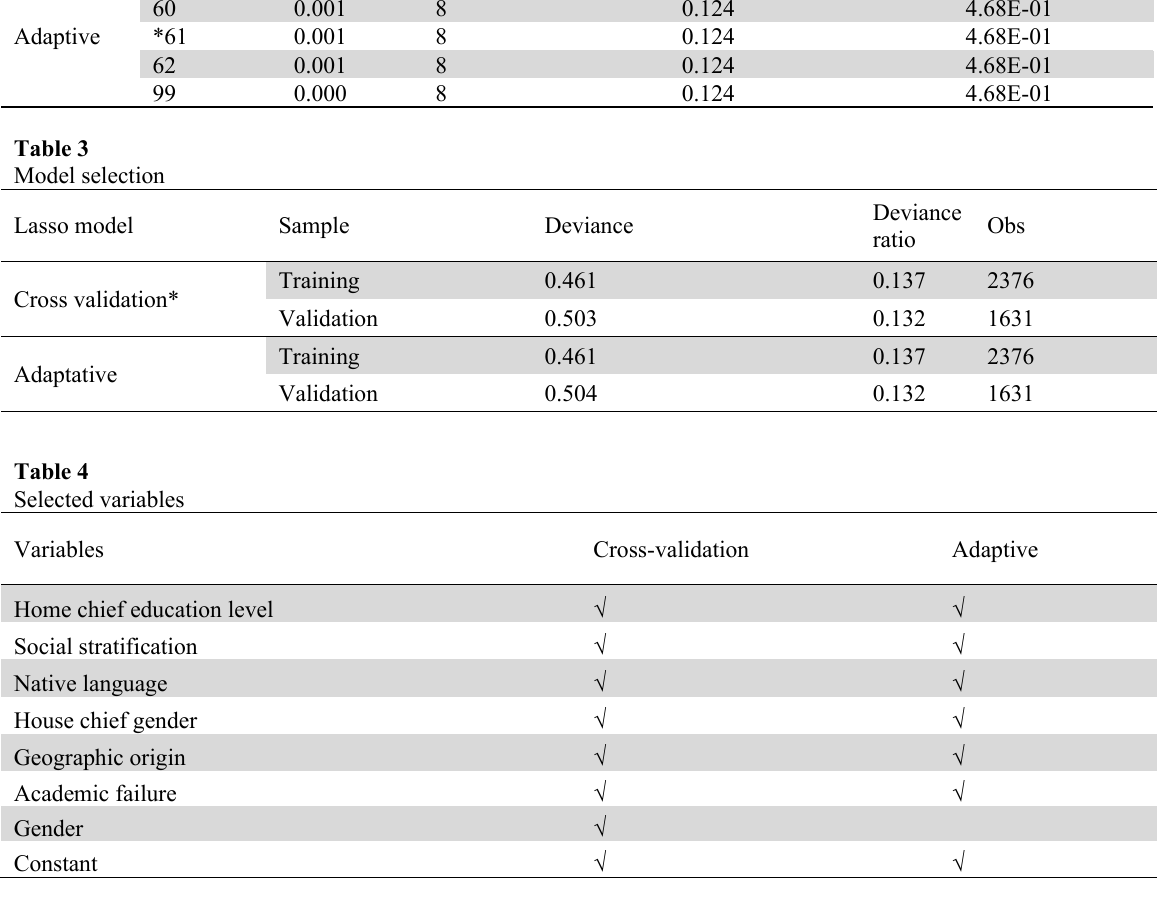
Table 1 portrays the initial variables for the current study. The Lasso technique provides the best set of variables for building the algorithm. Then, according to the Cross-Validation technique, the id selected was 10, while 61 was for Adaptive. In Table 3, when comparing both methods, the Adaptive model was higher than the Cross-validation in deviance. Hence, the Cross-Validation proposal was the best for the study. Moreover, Table 3 shows the variables employed by each model. Logit regression